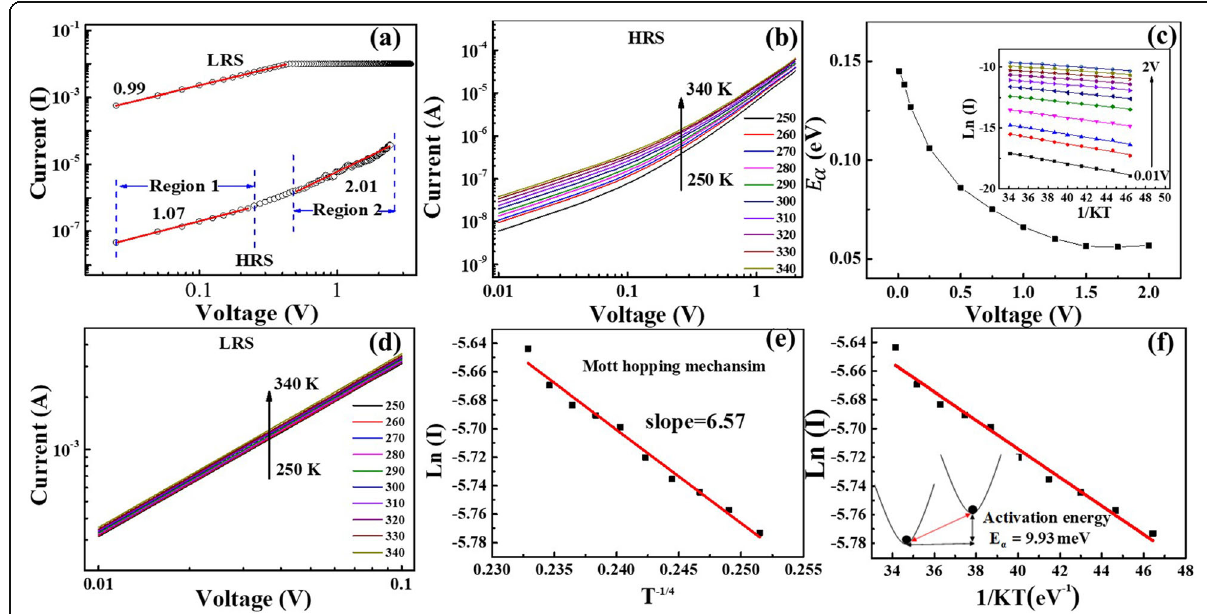
Fig. 6 a Linear fitting for the I-V curves using a log-log scale in the positive bias. b Temperature dependence of the current for the HRS from 250 K to 340 K. c The activation energy E α at different voltages is summarized. The inset shows an Arrhenius plot of the current temperature data at different voltages in the HRS. d Temperature dependence of the current for the LRS from 250 K to 340 K. e The relationship of conductivity ln I versus temperature T − 1/4 . The read voltage is 0.1 V. f The activation energy E α = 9.93 meV is